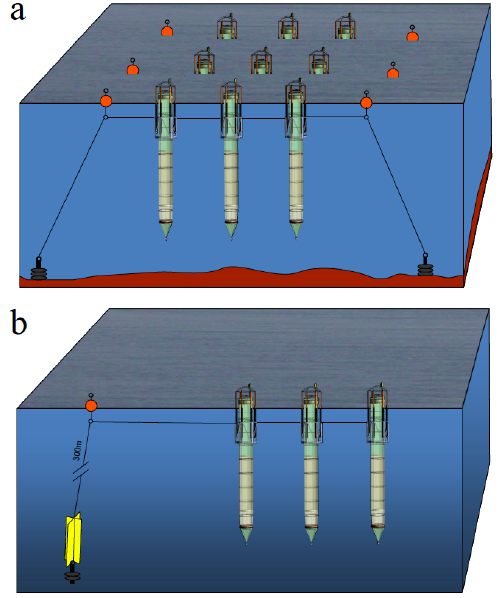
Fig. 5. Schematic drawing of the two modes of mesocosm opera- Fig. 5 4 tion: (a) mesocosms in moored mode in packs of three with anchor weight at each end as used in the Svalbard 2010 study; (b) meso- cosms in free-floating mode connected to a weighted drogue hang- ing from a buoy at 150m water depth. This approach was first tested in the 2011 campaign off